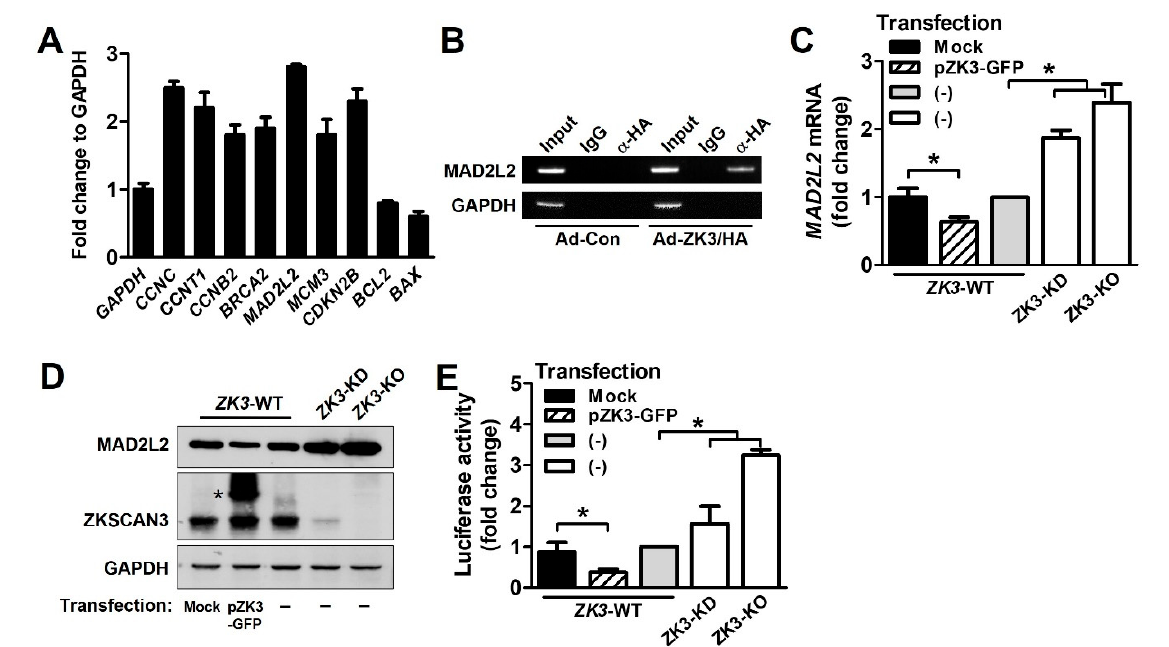
Figure 5. ZKSCAN3 acts as a transcriptional repressor of MAD2L2. ( A ) Chip assay and qPCR array were performed using EpiTect ® ChIP qPCR array Human Cell Cycle (QIAGEN). HCT116 cells were transduced with Ad-ZK3/HA or Ad-Con for 24 h and the crosslinked lysates were sonicated. The sonicated lysates were immunoprecipitated with anti-HA antibody or IgG and then with protein A. The eluted precipitates were applied to a qPCR array (QIAGEN). Representative qPCR results from the array are presented. Data are expressed as mean ± SD of triplicate experiments; GAPDH expression was used as the internal control. ( B ) Cells were infected with Ad-Con or Ad-ZK3/HA for 24 h, treated with formaldehyde, and sonicated. The cross-linked DNA–protein complex was immunoprecipitated using anti-HA ( α -HA) antibody or IgG followed by PCR amplification for MAD2L2 promoter. Immunoprecipitates obtained using IgG were used as the negative controls. Input chromatin (Input) refers to sonicated chromatin before immunoprecipitation. ( C ) Real-time qPCR was performed to evaluate the expression of MAD2L2 using mRNA extracted from the indicated cells. Data obtained from three independent experiments were used to represent a fold increase in mRNA levels. Statistical significance was determined using the Kruskal–Wallis test (* p < 0.05). ( D ) Western blotting was performed to evaluate the expression of MAD2L2 and ZKSCAN3 proteins; GAPDH was used as the loading control. *, ectopic ZKSCAN3 ( E ) The indicated cells were transfected with pGL-MAD2L2. The luciferase activity was determined. Data are expressed as fold change in expression compared to that in control cells, from three independent experiments; they are expressed mean ± SD. Statistical significance was determined using the Kruskal–Wallis test. (* p <